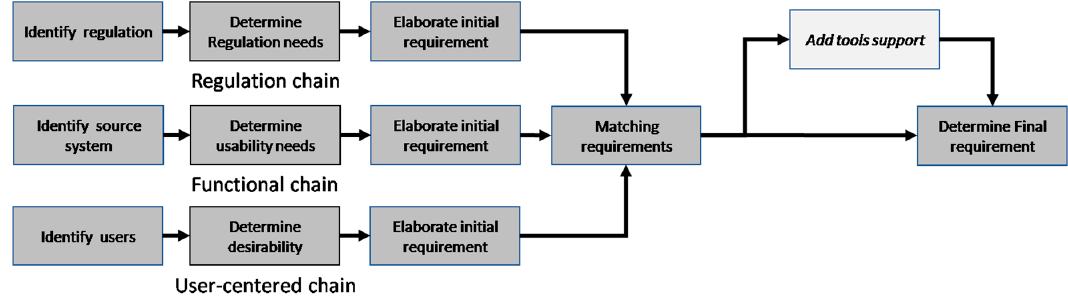
Figure 2. Methodology for determination of requirements for spatial information services for Participatory Urban Planning Monitoring adapted from Malinowski and Zimányi [14].